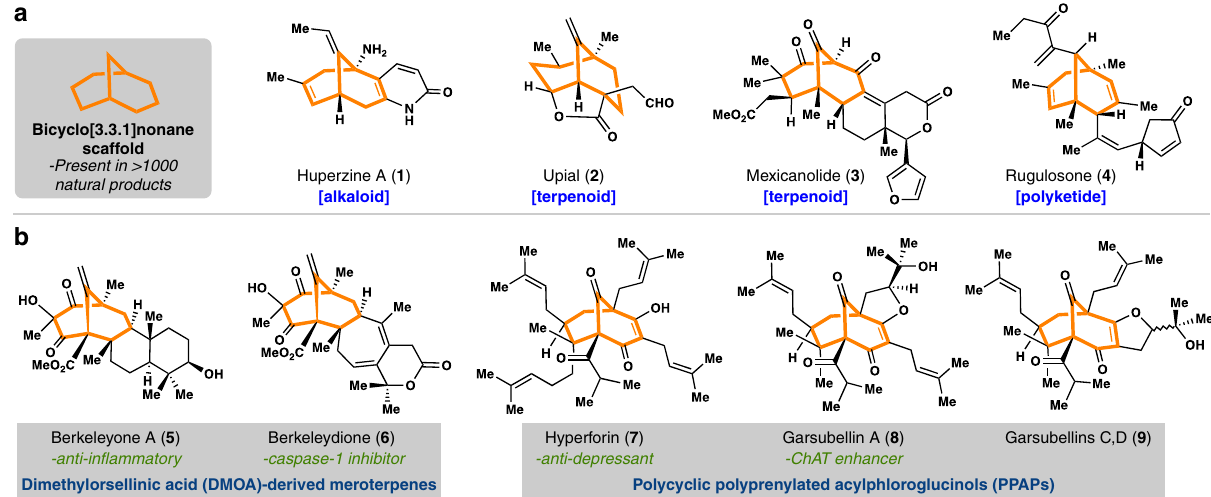
Fig. 1 Complex bicyclo[3.3.1]nonane-containing natural products. a Members are found across all areas of natural product space and therapeutic area. b The large family of terpene-polyketide hybrids (meroterpenes) as a particularly proli fi c sources of bicyclo[3.3.1]